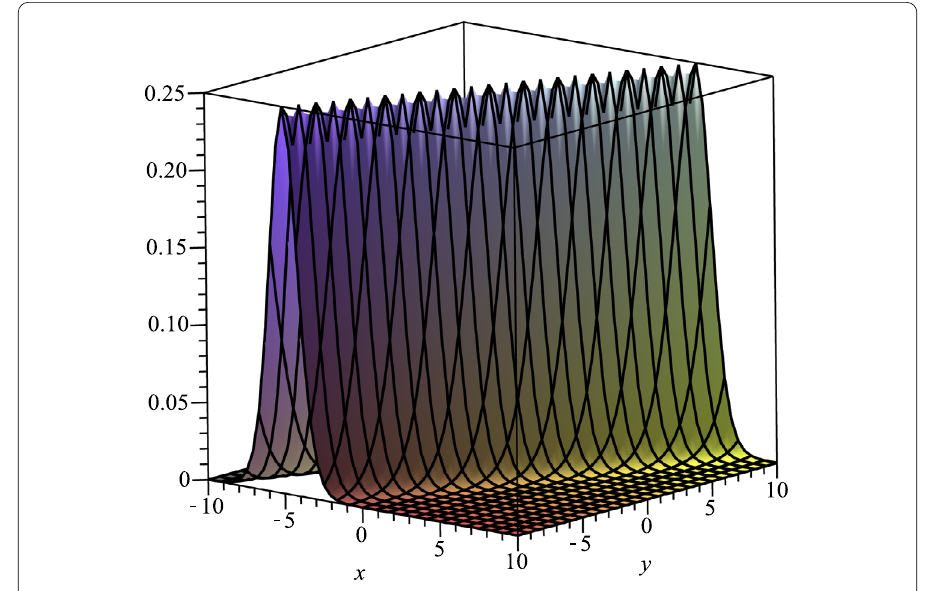
Figure 3 The solution of the mZK with k = 1, t =